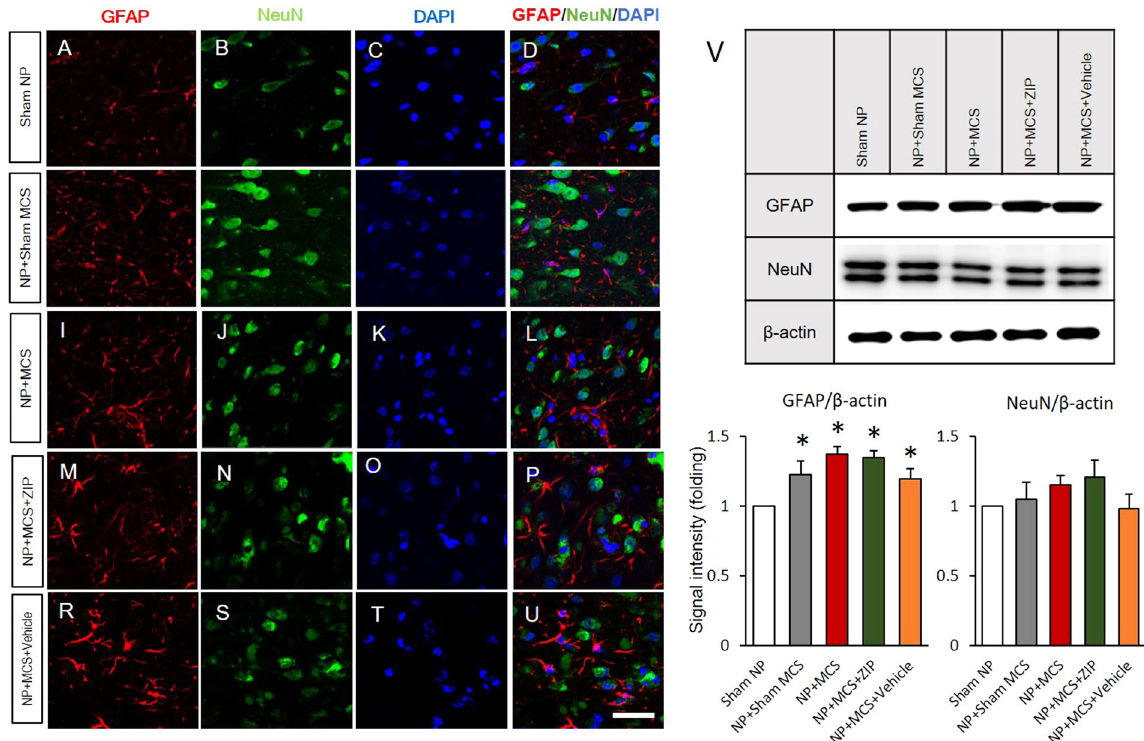
Figure 6. Comparison of neuronal and glial cell alterations in the ACC. Results of double staining of rat brain slices for the astrocyte marker GFAP and neuron marker NeuN are shown. DAPI counterstaining is indicated by blue fluorescence. ( A – D ) The expression of GFAP and NeuN in neuronal cells in sham NP rats is shown. ( E – U ) GFAP immunoreactivity in the ACC was elevated in all experimental groups. However, the expression levels of NeuN did not significantly change in all animal models used (scale bar, 50 μ m). ( V ) Western blot analysis was used to detect GFAP and NeuN protein levels in the ACC. GFAP expression in the ACC significantly increased in the NP + Sham MCS, NP + MCS, NP + MCS + ZIP, and NP + MCS + Vehicle rats. Elevated NeuN expression was detected in NP + MCS and NP + MCS + ZIP rats, but significant changes were not observed. β -Actin was used as a loading control. * P < 0.05 compared with sham NP and n = 4 rats for each